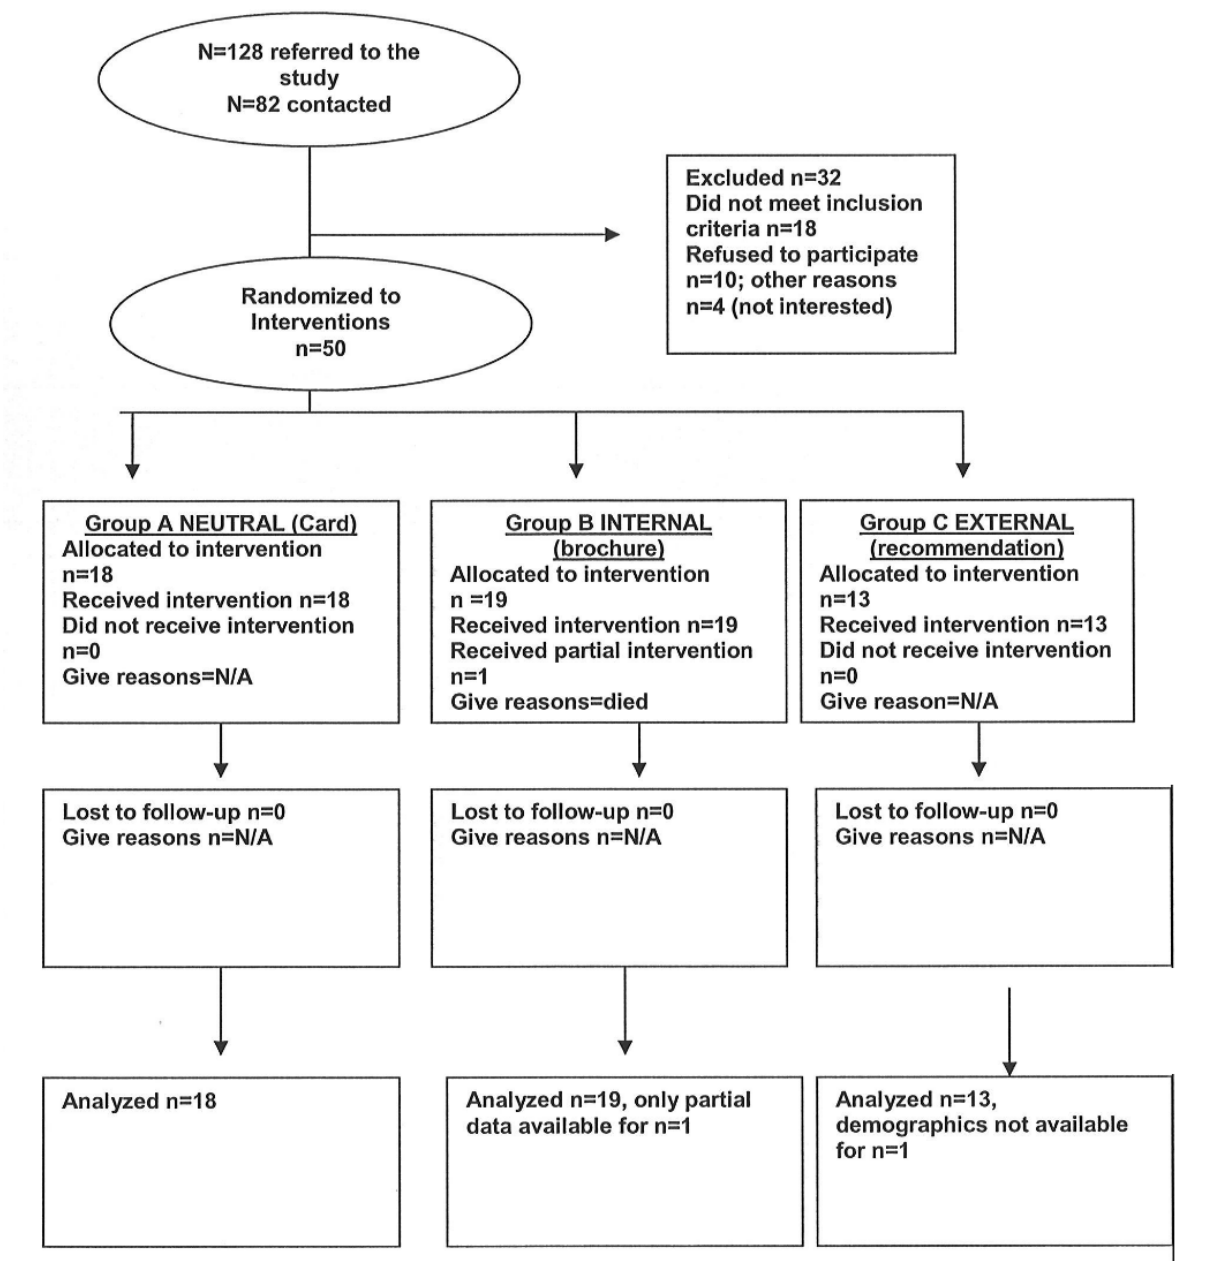
Figure 1. CONSORT